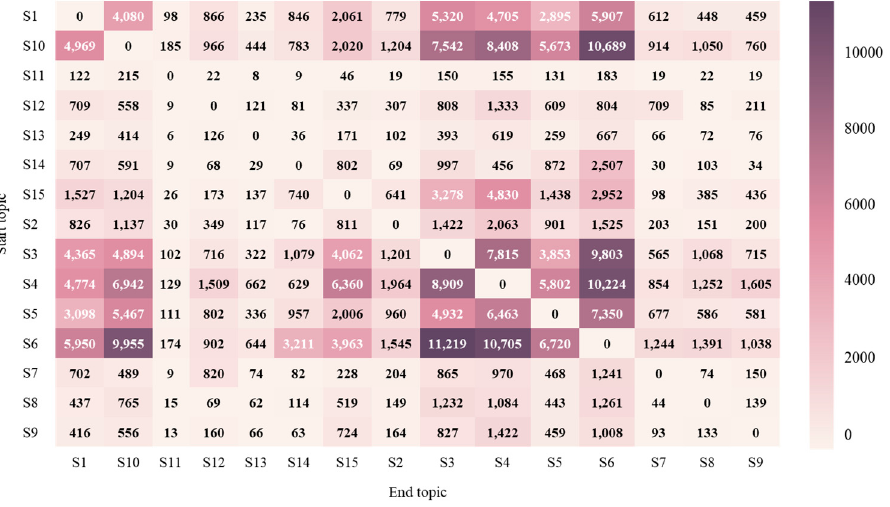
Figure 10. Heat map of user semantic change events.